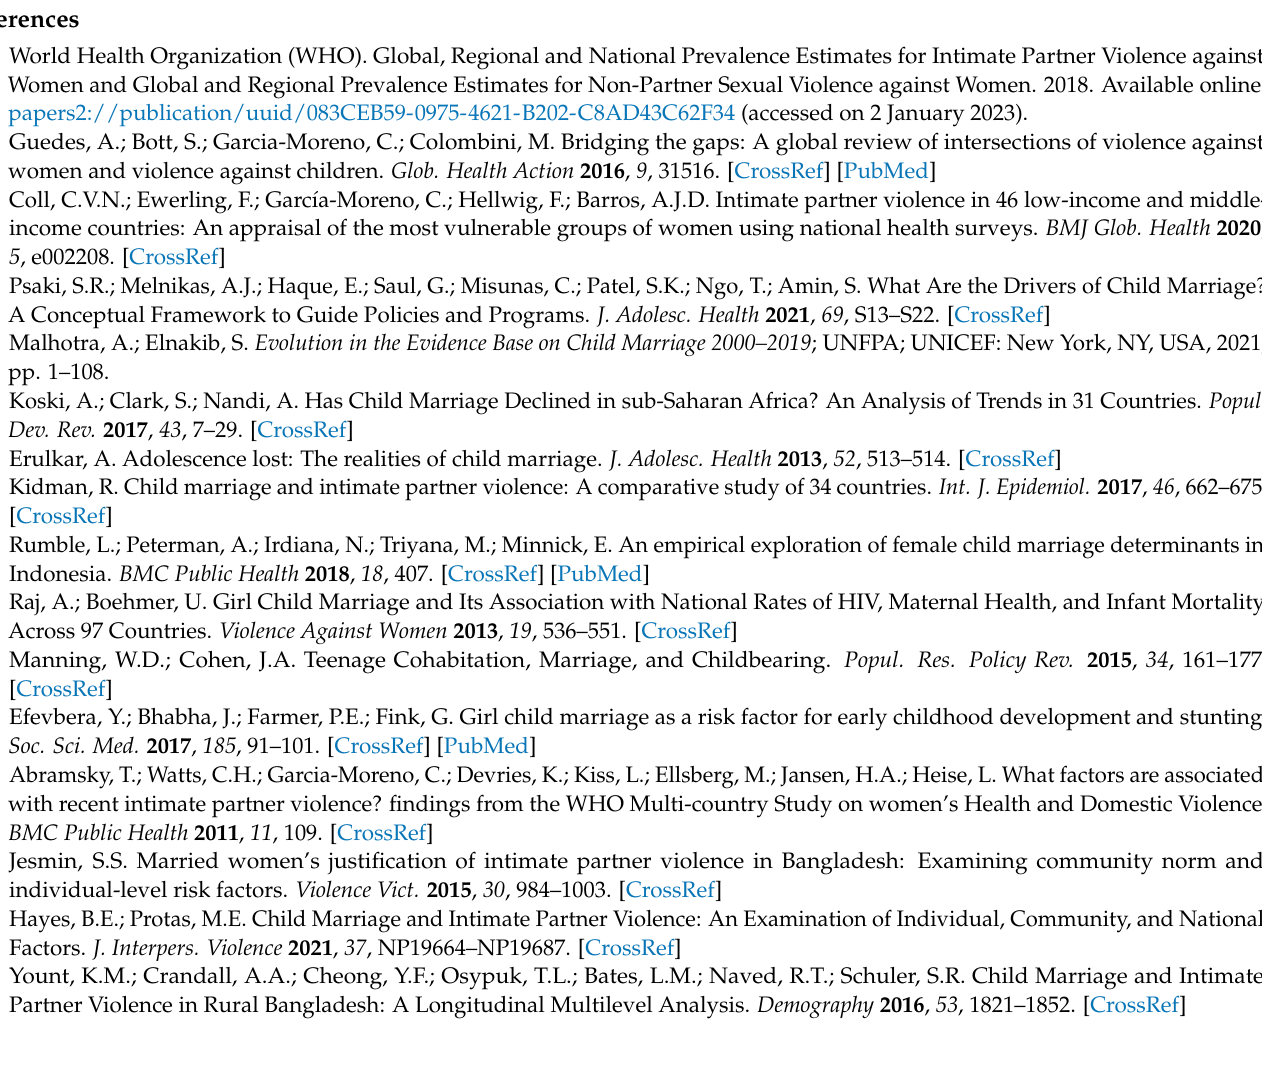
Table S5: Regression coefficients for the selected powers of the pooled multilevel logistic regression models for women aged 25 to 39 years. Each model corresponds to one type of